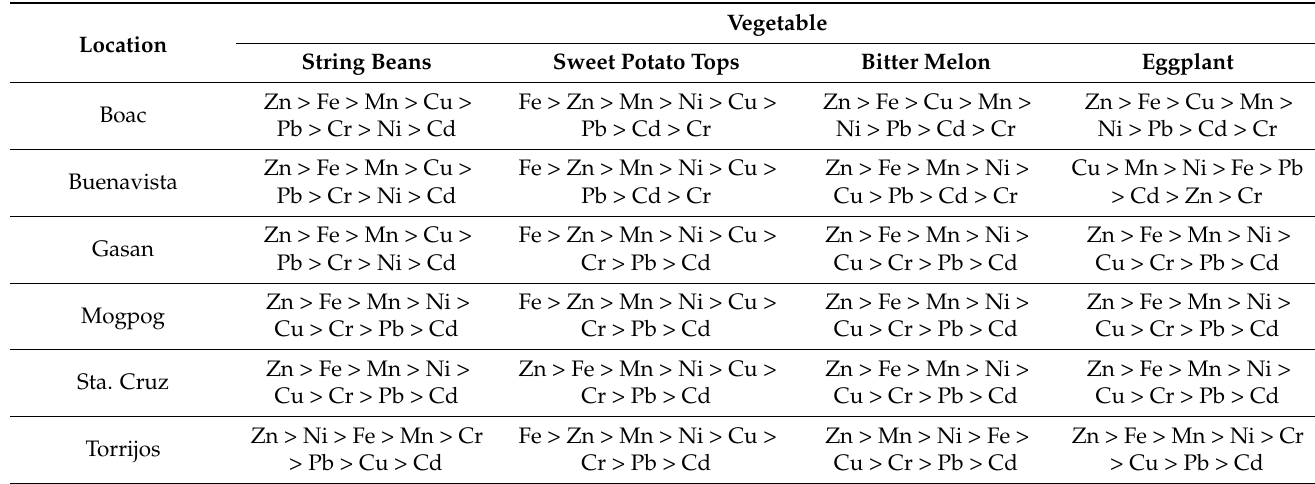
Table 6. Target cancer risk due to the consumption of vegetables with elevated heavy metal concen- trations.